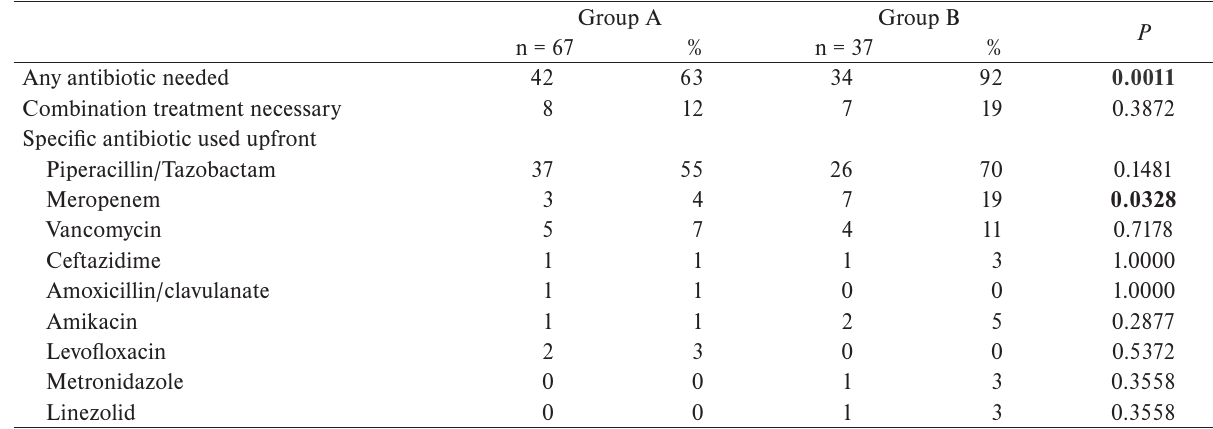
Table 3. Antibiotic treatment.